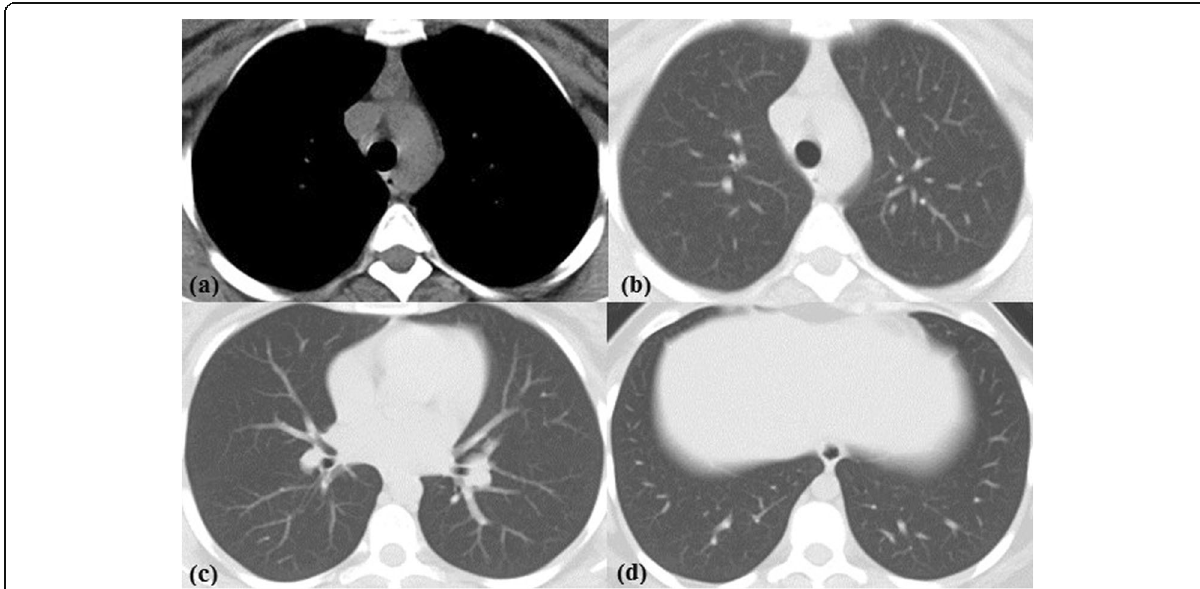
Fig. 4 Thymic hyperplasia in a 23-year-old female with RT-PCR proved COVID-19. a Non-contrast CT chest axial cut mediastinal window shows retrosternal well-defined triangular-shaped soft tissue density with straight borders with less macroscopic fat than expected for age. b – d Axial lung window showing no lung abnormality